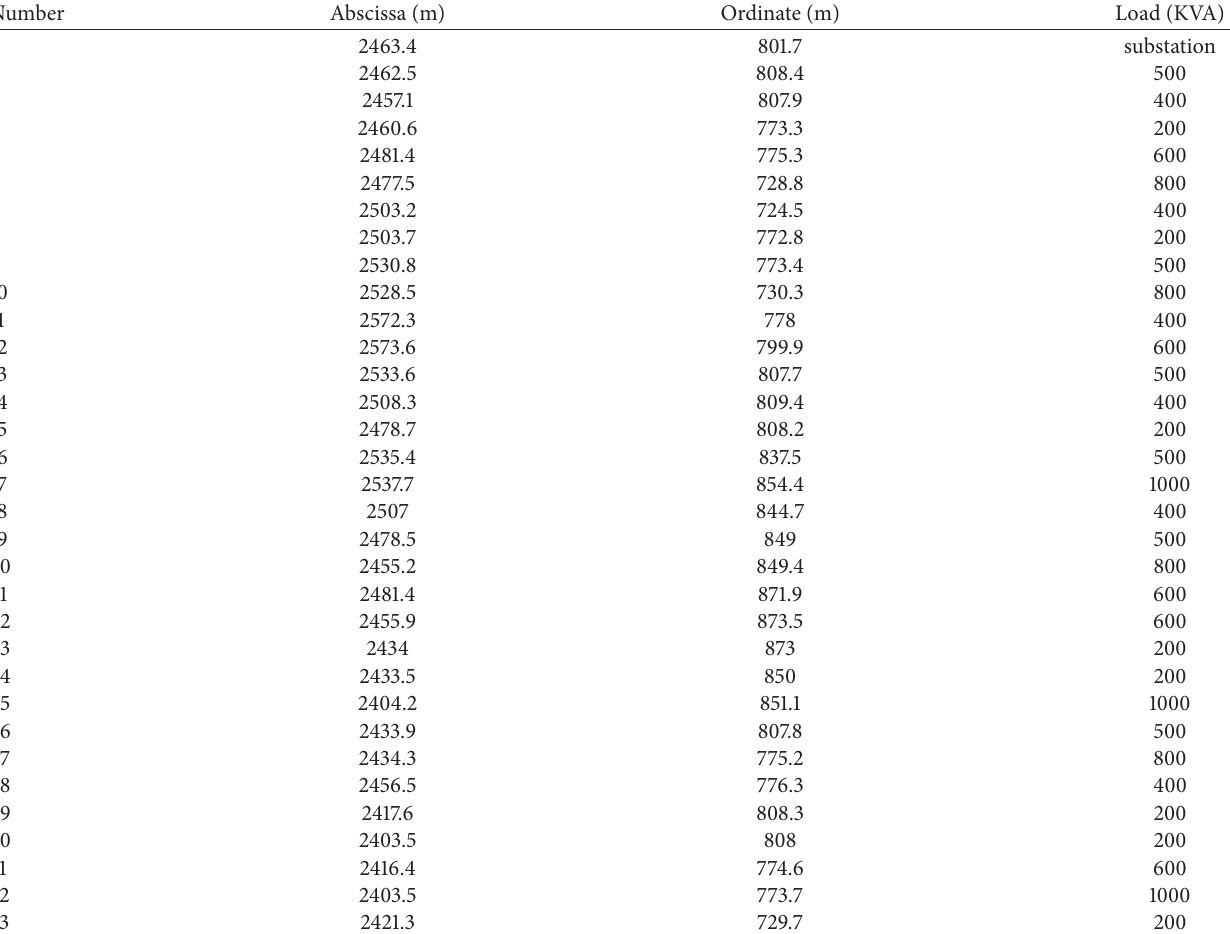
Table 1: The coordinates and state of load points.